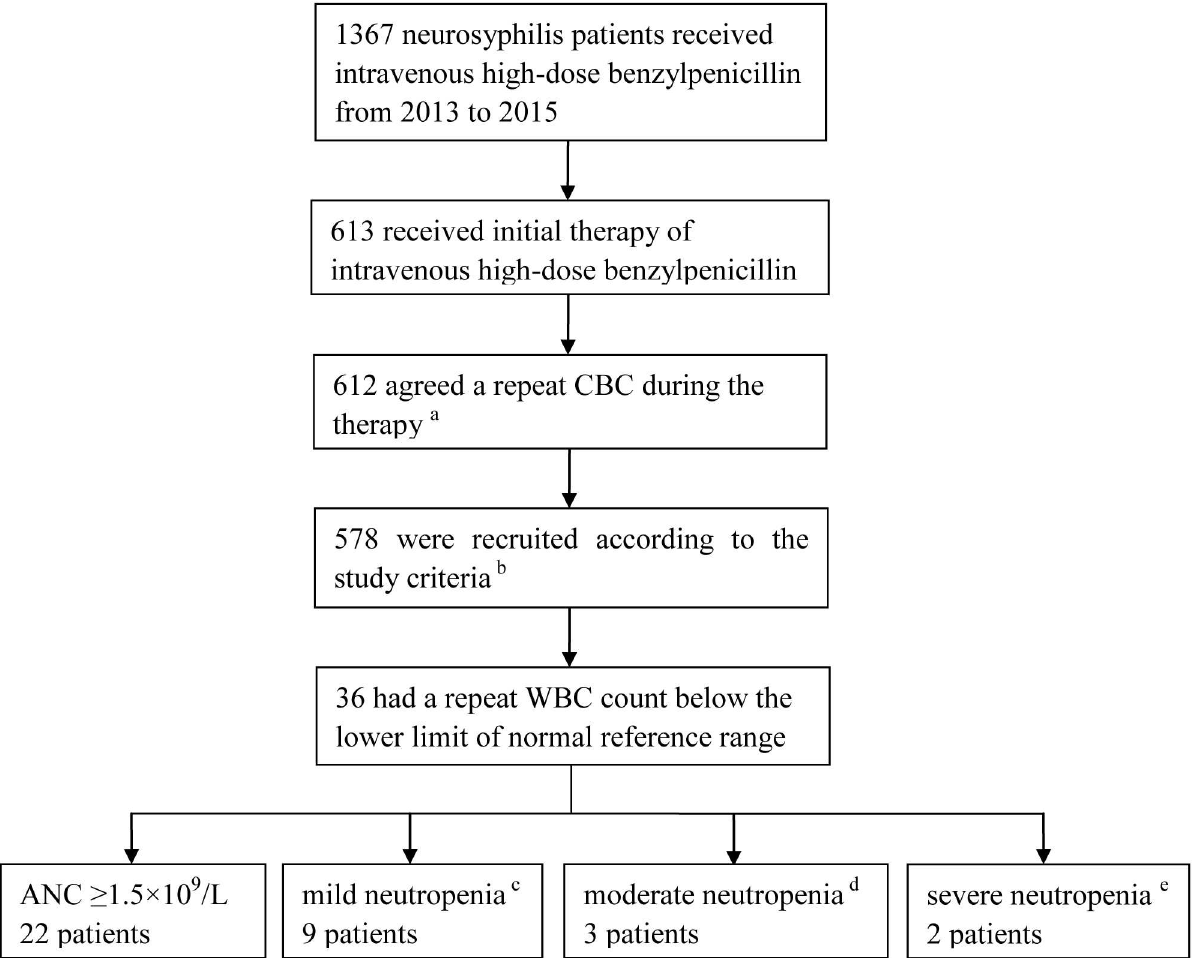
Fig 1. Flowchart of neurosyphilis patients included in the dataset. Abbreviation: CBC, completeblood count; WBC, white blood cell; ANC, absoluteneutrophilcount. a One patient did not receivea repeat CBC due to some personal reasons. b See detailedcriteria in the text. c 1 × 10 9 /L (cid:20) ANC < 1.5 × 10 9 /L d 0.5 × 10 9 /L (cid:20) ANC < 1 × 10 9 /L e ANC < 0.5 × 10 9 /L